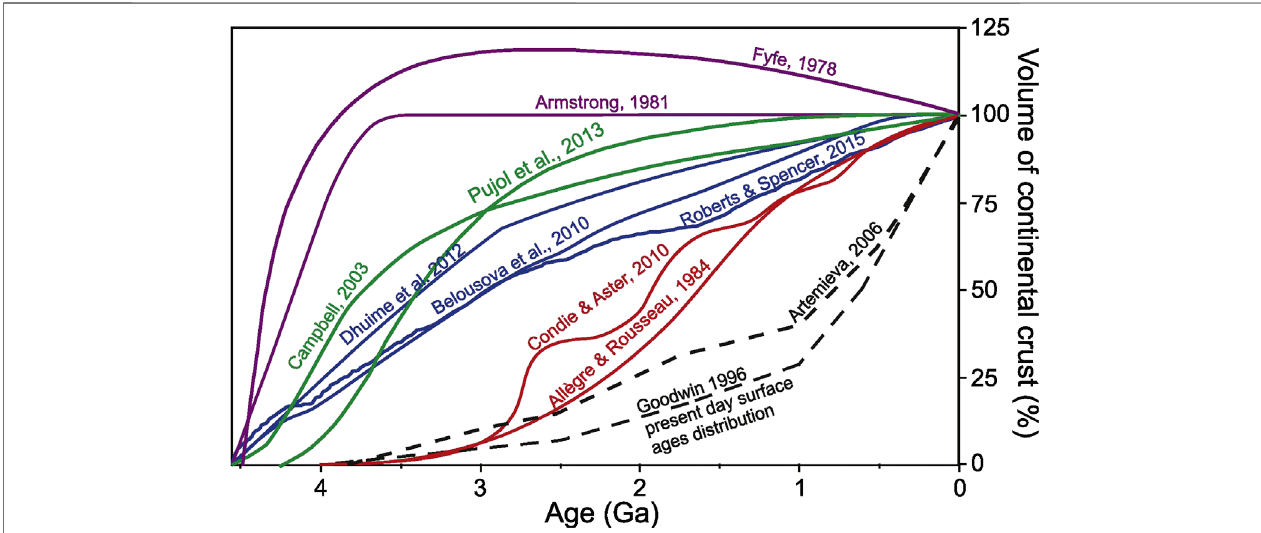
FIGURE3| The growth models ofthecontinentalcrust relative toits present-dayvolume (Reproduced from Cawoodand Hawkesworth (2019)underthe Creative Commons CCBY license). Note that the curves of Belousova et al. (2010), Dhuime et al. (2012), Roberts and Spencer (2015), Campbell (2003), Pujol et al. (2013), all of which used different proxies, predict similar volumes of continental crust at ∼ 3 Ga.